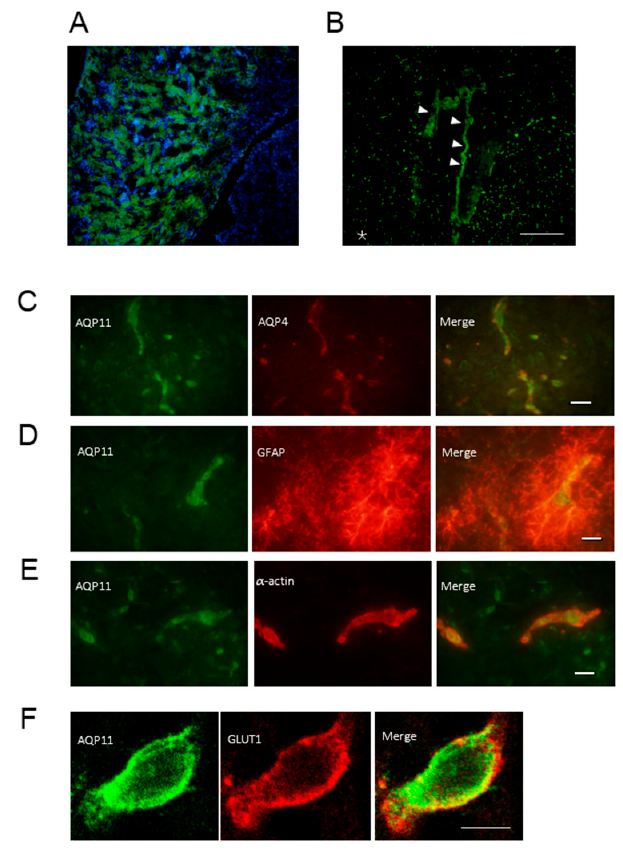
Figure 2. Localization of AQP11 in the kidney and brain ( A ) Immunofluorescence staining for AQP11 (green) and 4 ′ ,6-diamidino-2-phenylindole dihydrochloride (blue) for nuclear counterstaining in the kidney of the wild type at P28; ( B ) Immunofluorescence staining for AQP11 (green) in the fourth ventricle of the wild type at P28. The arrow heads indicate the choroid plexus. The asterisk (*) indicates the cerebral grey matter. Scale bar, 200 µm; ( C – F ) The double immunofluorescence of AQP11 (green) in the cerebral cortex of the wild type at P28; ( C ) with AQP4 (red; the scale bar, 20 µm); ( D ) with glial fibrillary acidic protein (GFAP) (red; the scale bar, 10 µm); ( E ) with α -actin (red; the scale bar, 10 µm); and ( F ) with GLUT1 (red; scale bar, 5 µm). Sections were viewed and photographed with a fluorescent microscope ( A – D ) or confocal scanning microscope ( F ).